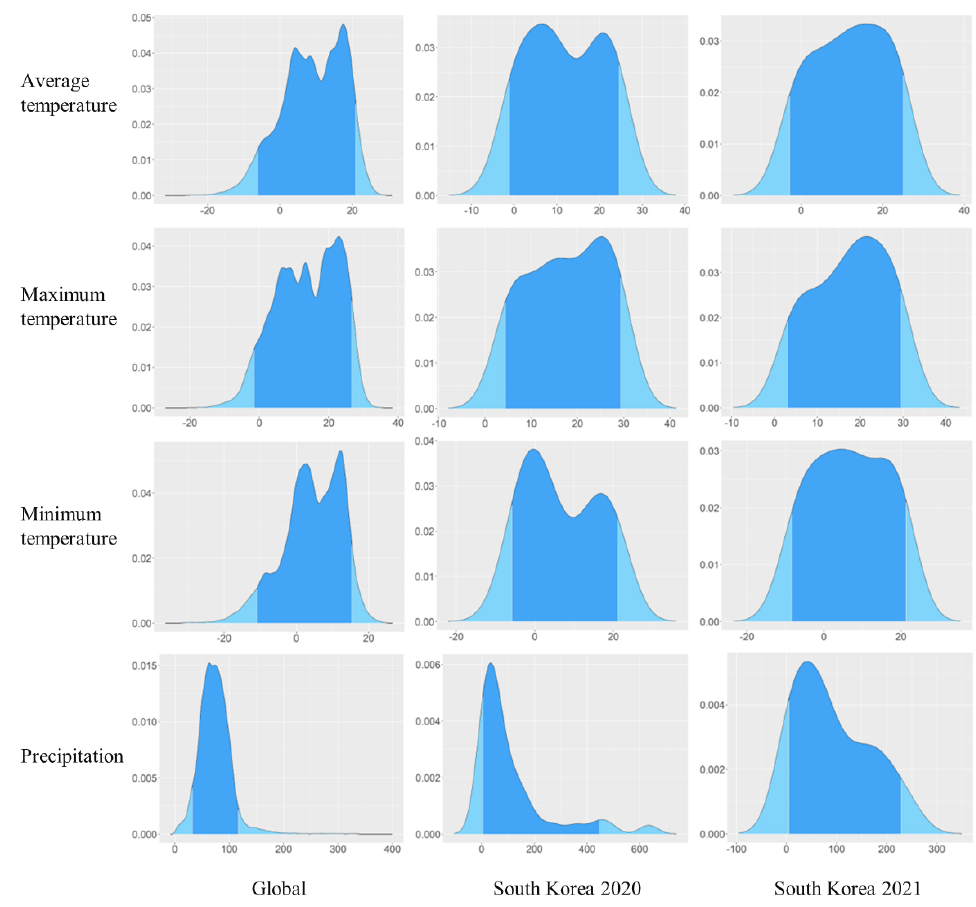
Figure 2. Kernel density distribution of the major climatic factors in global occurrence coordinates obtained for 30 years (1970 – 2000), and in domestic field surveys in 2020 and 2021. Dark blue areas include 90% of the total distribution with 5% and 95% of the lower and upper threshold, respectively (X-axis has the unit of temperature (°C), and precipitation (mm), while Y-axis shows the kernel density).